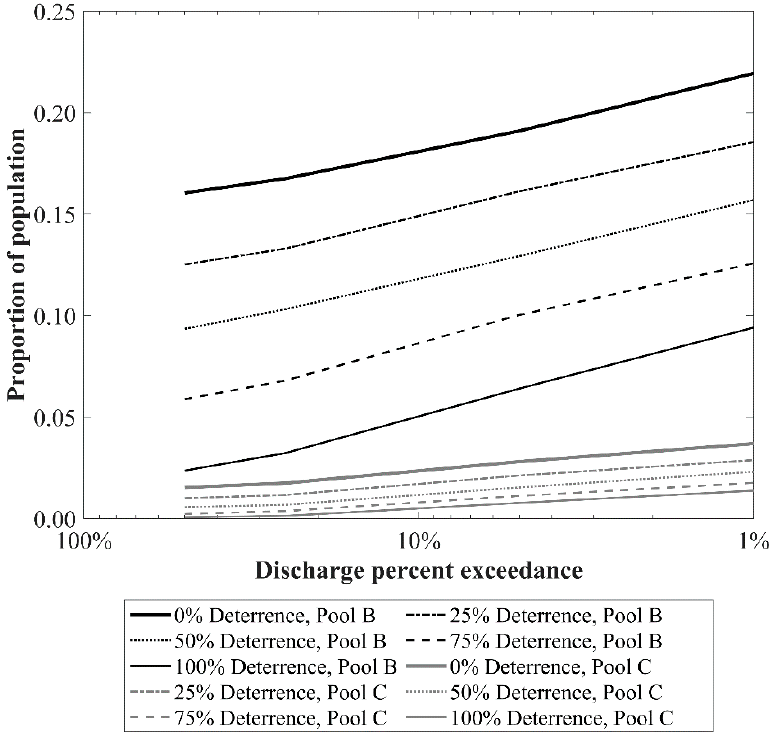
Figure 6. The proportion of upstream swimming silver carp passing through either a single LD (black lines) or two consecutive LDs (grey lines) equipped with nonphysical deterrents of different efficacies and using modified spillway gate operations.